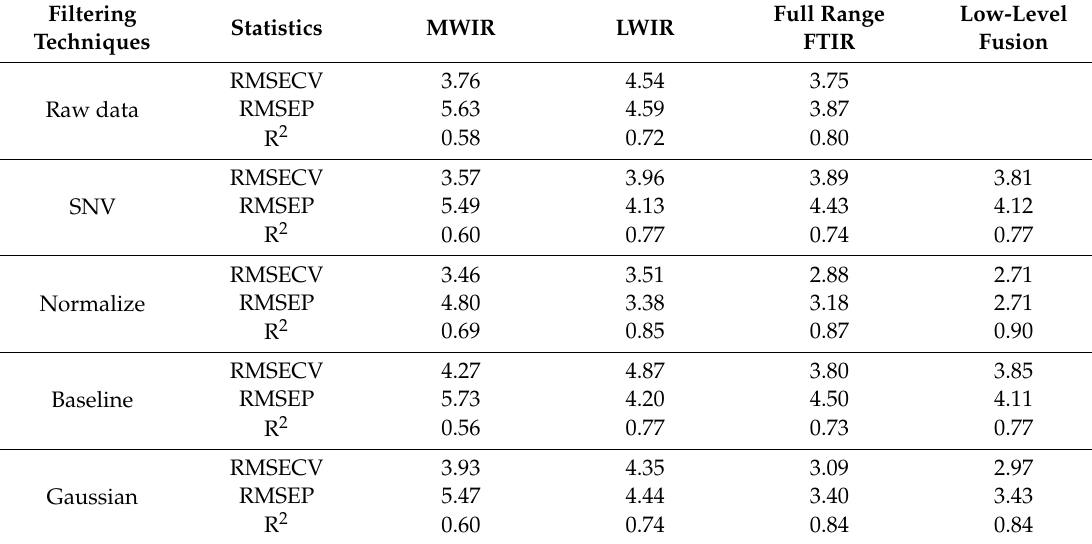
Table 3. Summary of the predictive performances of mid-wave infrared (MWIR), long-wave infrared (LWIR), full-range FTIR, and low-level data fusion models for Fe concentration prediction.